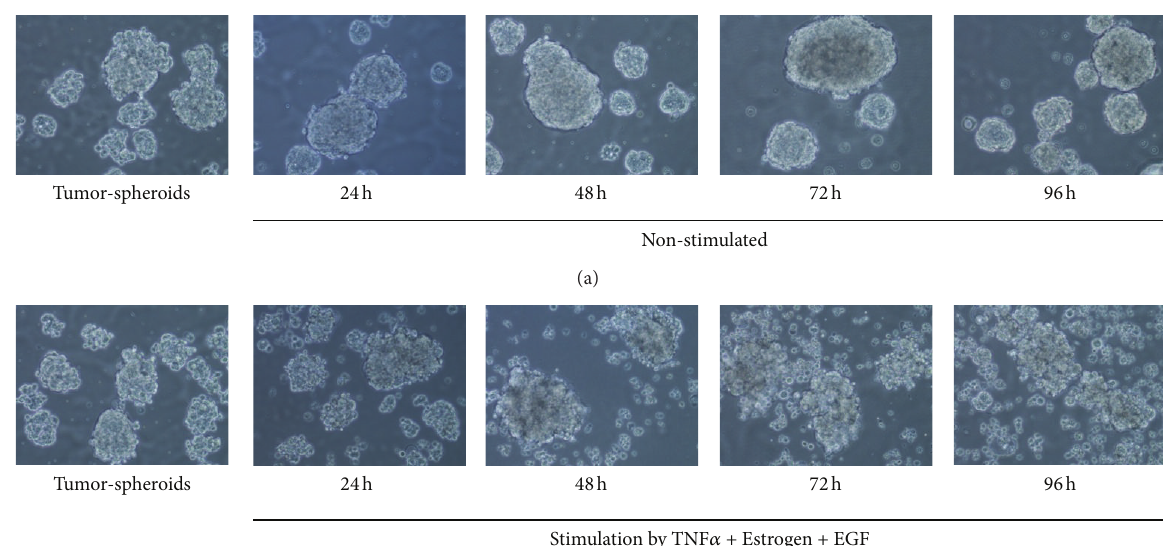
Figure 9: In response to combined stimulation by TNF 𝛼 + Estrogen + EGF, breast tumor cells migrate out of tumor-spheroids. Non- stimulated breast tumor cells were plated in nonadherent conditions, and tumor-spheroids were allowed to form for 72 hr. Then, the cells were either non-stimulated (a), or stimulated by TNF 𝛼 + Estrogen + EGF (concentrations as in Figure 1) (b) for additional 24–96hr. Non- stimulated cells: cells grown with the diluents of the above factors. Cells were photographed daily using light microscopy at × 10 magnification. Cell viability tests indicated that single cells migrating out of tumor-spheroids formed in the presence of TNF 𝛼 + Estrogen + EGF stimulation were alive. In all panels, the results are from a representative experiment of 𝑛 ≥ 3 . The surface expression of E-cadherin by the cells that were included in this analysis is shown in Table 1 and in Figure